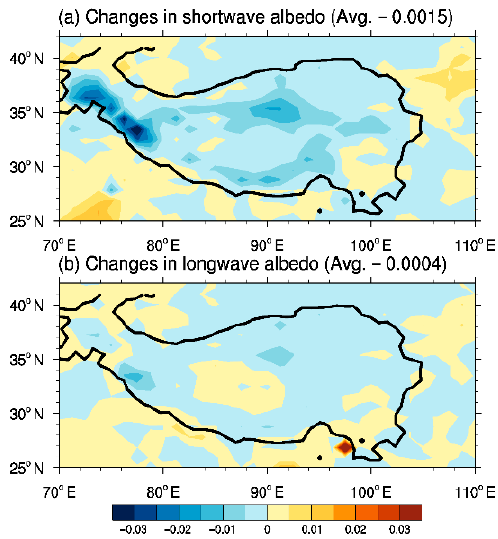
Figure 8. Changes in ( a ) surface shortwave albedo and ( b ) longwave albedo.